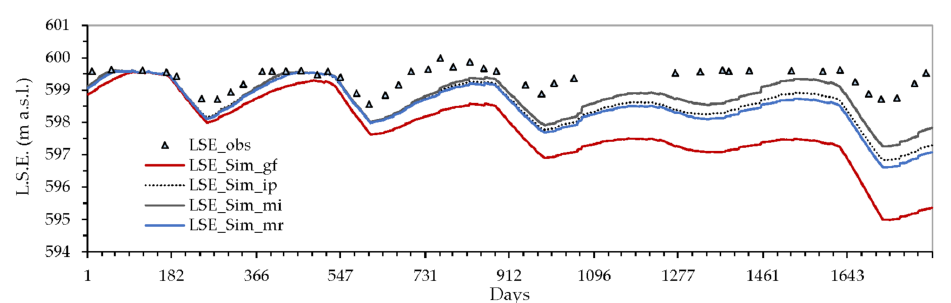
Figure 8. Water level of Lake Zazari 1 January 2013–31 December 2017 and future climate change